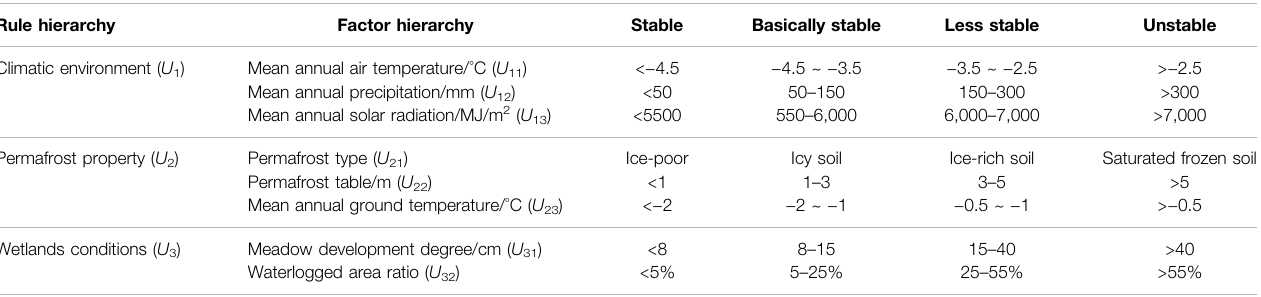
TABLE 6 | Evaluation standard for engineering stability of permafrost wetlands.